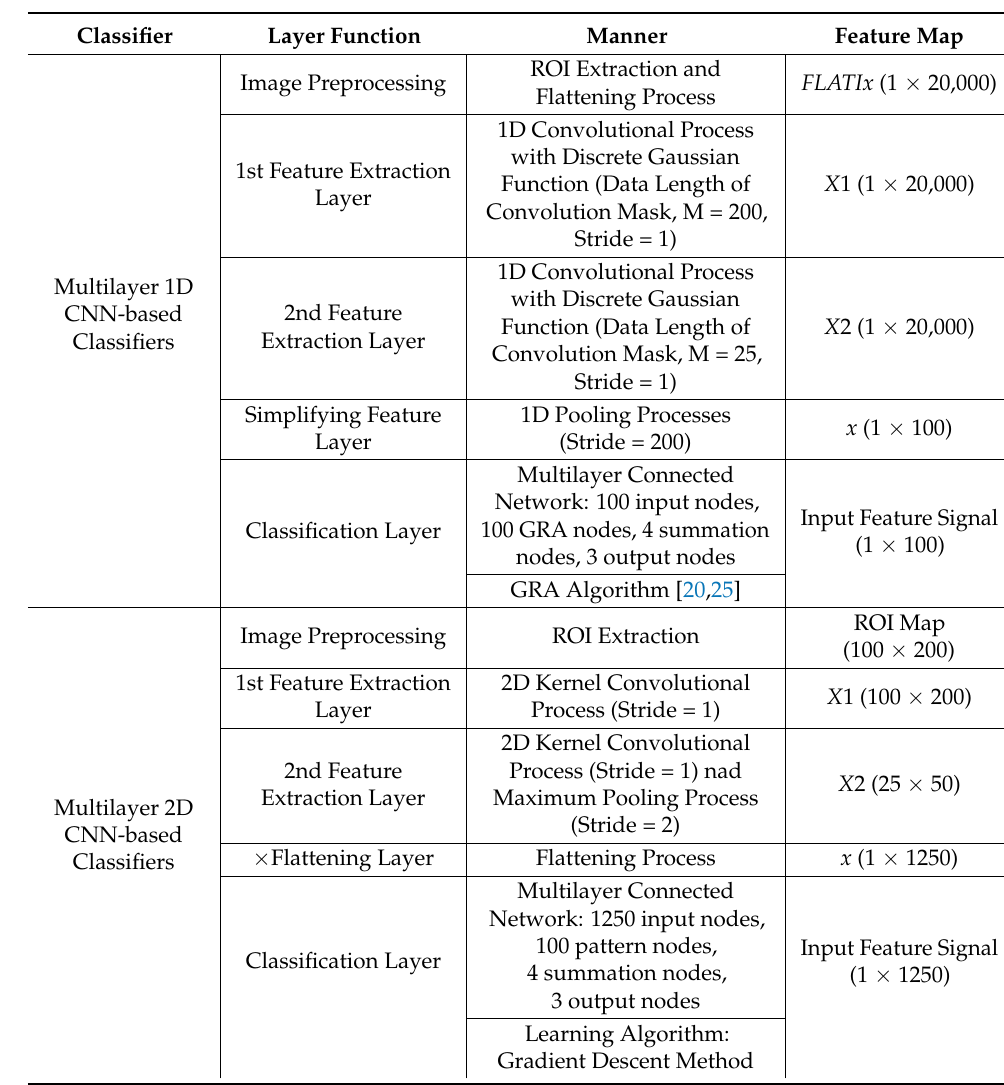
Figure 5. Distributions and statistics of normal condition (100 subjects), mild/moderate cardiomegaly (48 subjects), and severe cardiomegaly (52 subjects). ( a ) Training dataset for training classifier and ( b ) testing dataset for validating classifier. Table 1. Related data of the multilayer 1D and 2D CNN-based